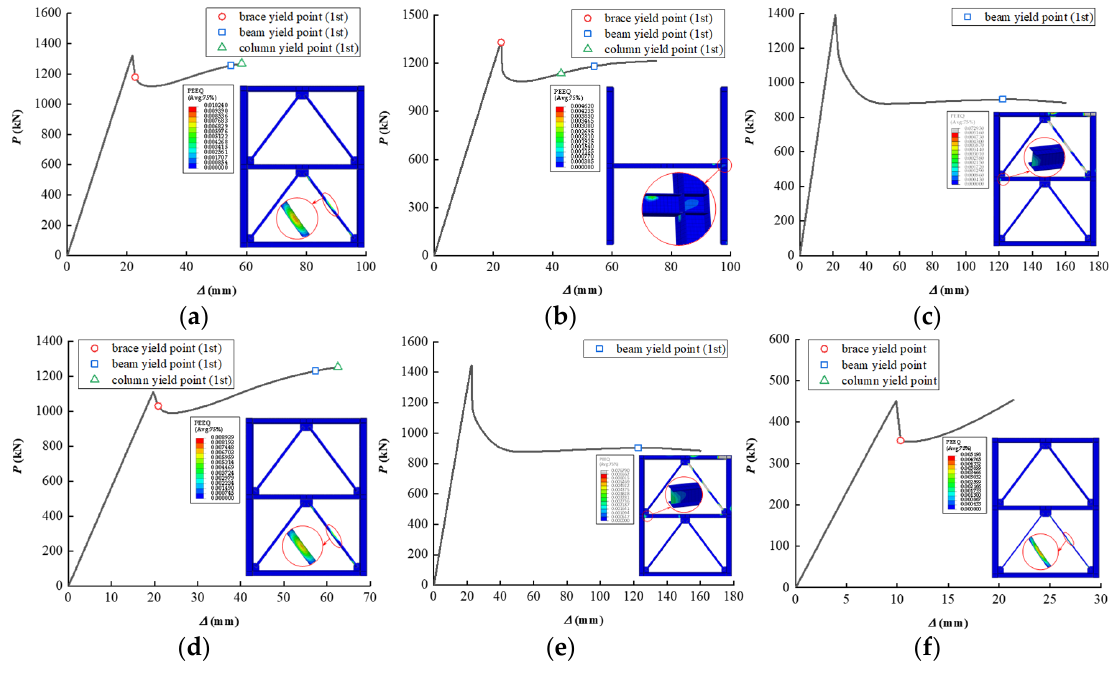
Figure A5. The predicted PEEQ distributions of a typical floor with η = 0.2. ( a ) case 32, the basic model obtained by the proposed method; ( b ) case 35, decreased section area of the column web; ( c ) case 38, thicker braces; ( d ) case 41, thinner braces; ( e ) case 44, larger external brace diameter; ( f ) case 47, smaller external brace diameter.